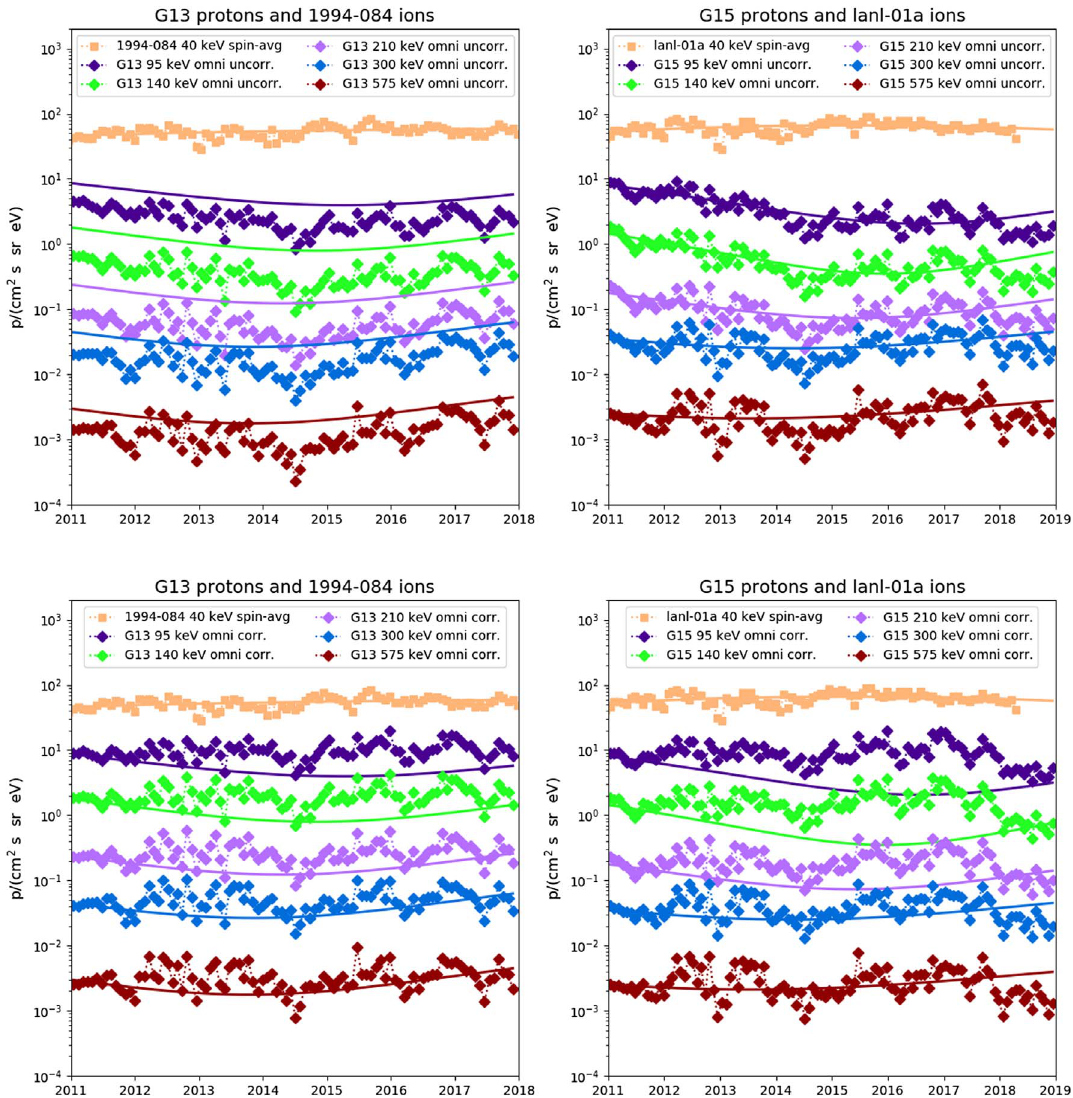
Fig. 10. Bartels-rotation averages of MPA 40 keV ion and MAGPD proton fl uxes, uncorrected (top) and corrected (bottom). (Left) GOES-13 and 1994-084 fl uxes and fi ts, 2011 – 2017. (Right) GOES-15 and LANL-01A fl uxes and fi ts, 2011 – 2018. The second-order fi ts to the fl uxes are indicated by solid lines in both the uncorrected (top) and corrected (bottom) plots; the GOES-13 fi ts are to the data with the “ day 1 ” correction applied. (The energy unit is converted from keV to eV to be consistent with the Denton et al., 2015, 2016